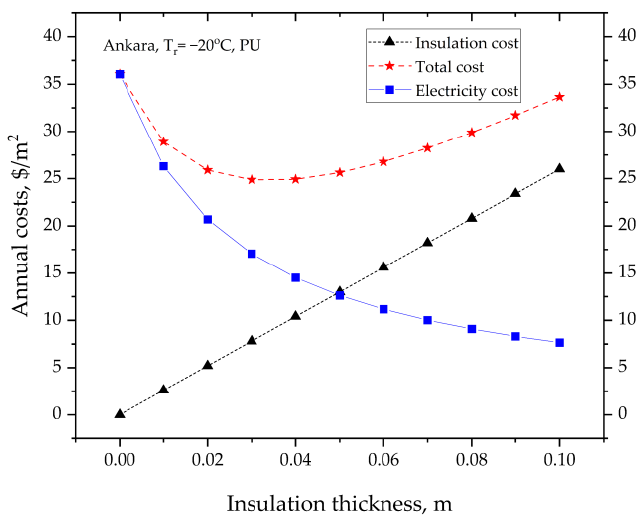
Figure 6. Electricity, insulation, and total costs at − 20 ◦ C reference temperature for PU insulation material in Ankara.